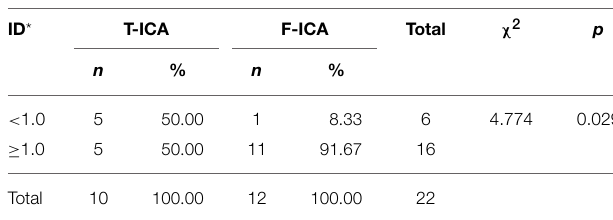
TABLE 2 | Comparing the intensity distribution (ID) of source signals in C3/C4 between T-ICA and F-ICA